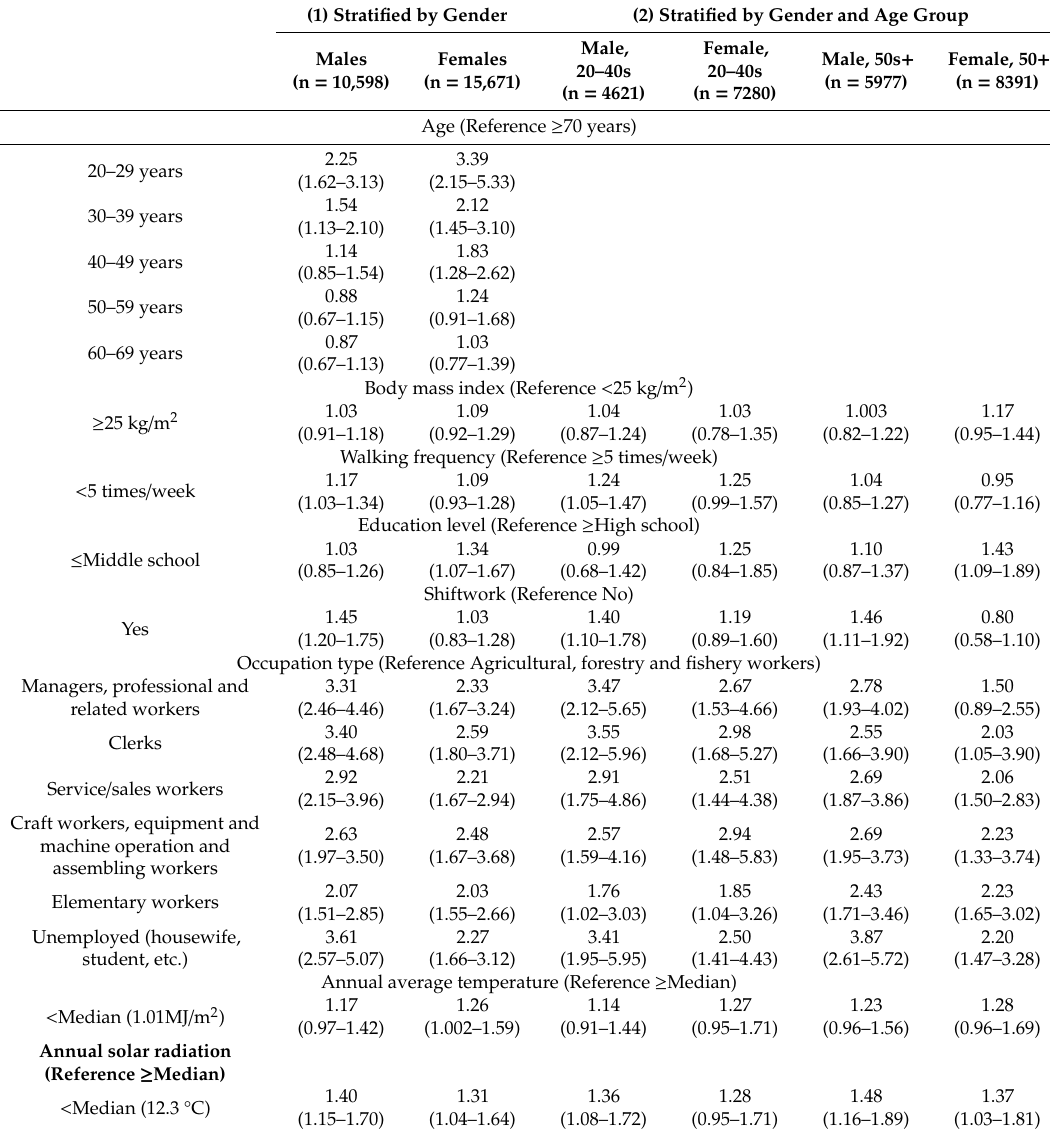
Table 3. Logistic regression analysis of association between occupational and environmental factors and vitamin D deficiency ( < 20 ng / mL) from KNHANES 2010–2014, stratified by gender and age. (1) Stratified by Gender (2) Stratified by Gender and Age Group Males Females (n = 10,598) (n =